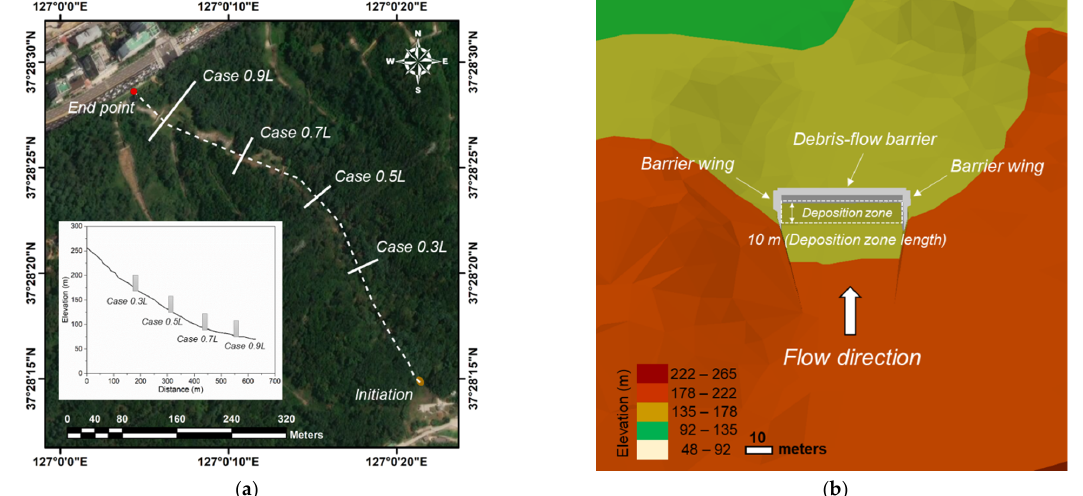
Figure 1. Illustration of barrier installations: ( a ) barrier locations; ( b ) detailed map view.